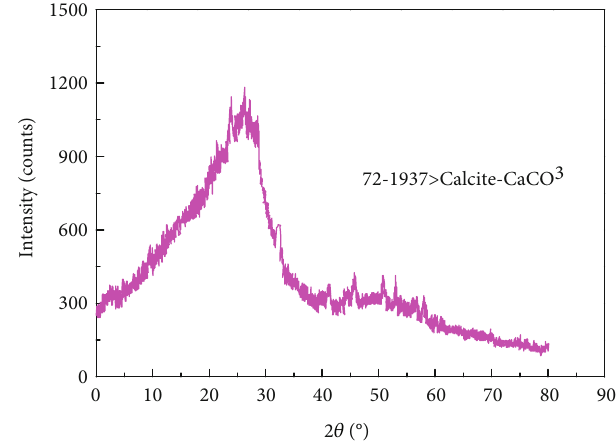
Figure 4: XRD-based composition analysis of coal specimens.